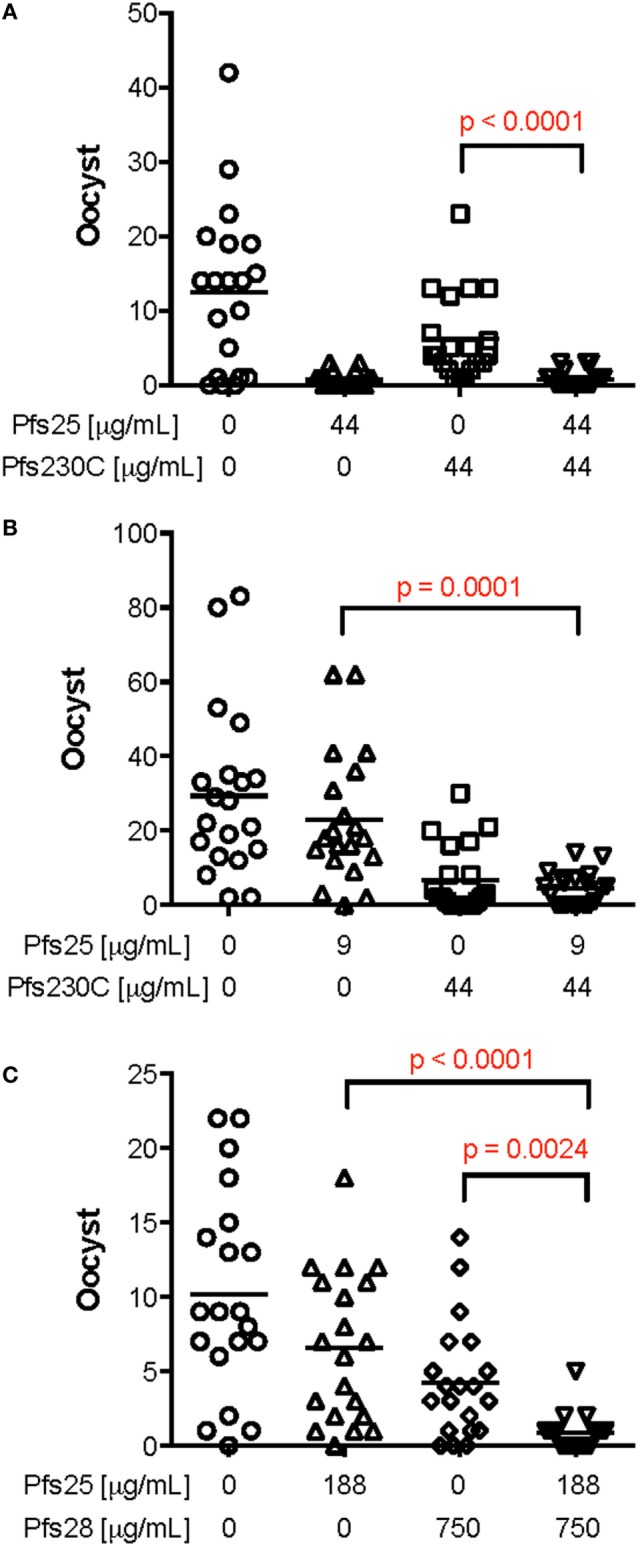
Effect of mixing mouse IgG induced by vaccination against Pfs25, Pfs230C or Pfs28 in standard membrane-feeding assay (SMFA). Total IgG was purified from pooled day 70 serum from mice vaccinated with chimpanzee adenovirus 63 (ChAd63)–modified Vaccinia Ankara (MVA) expressing Pfs25, Pfs230C, or Pfs28. The purified IgG from mice vaccinated with Pfs25 was mixed with IgG from mice vaccinated with Pfs230 [(A,B) the anti-sera used to purify both anti-Pfs25 and anti-Pfs230 IgGs were from experiment 3]. In addition, IgG from mice vaccinated with Pfs25 was mixed with IgG from mice vaccinated with Pfs28 [(C) both IgGs from experiment 4] at different concentrations. These IgG mixtures or IgG against the single antigens were fed to Anopheles stephensi mosquitoes in SMFA. Data points represent the number of oocysts in individual mosquitoes, and the lines show the arithmetic mean. IgG from mice immunized with ChAd63–MVA expressing green fluorescent protein were used as a negative control (the first left column in each panel). There are significant differences in oocyst density among single IgGs and IgG [p < 0.0001 (A), p < 0.0001 (B), and p < 0.0001 (C) by Kruskal–Wallis tests], and p values (Dunn’s multiple comparison posttests) are shown when there are significant differences between mixture and single IgG in each panel.